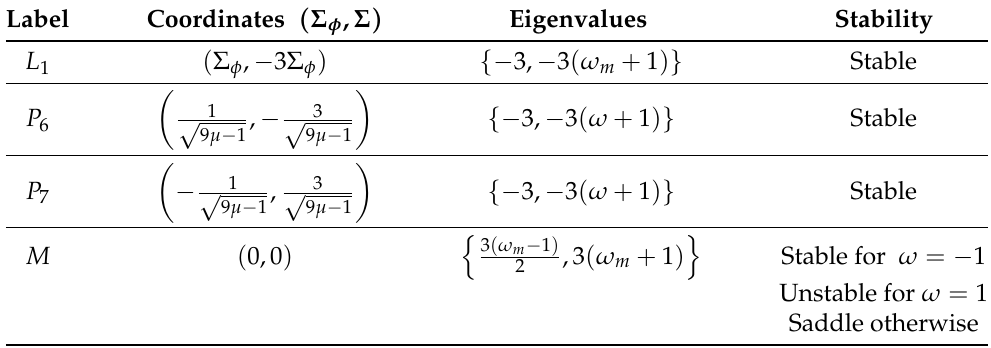
Table 6. Equilibrium points of System (85) and (86) for (cid:101) = − 1 with their eigenvalues and stability.